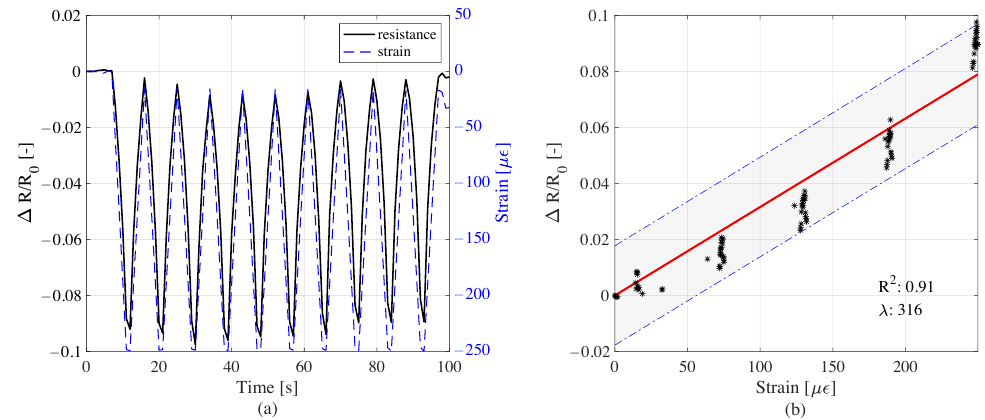
Figure 9. Sensitivity response of the beam sample under the cyclic compression load: ( a ) variation of resistance and the induced strain time histories; ( b ) resistance variation versus strain, and linear model of sensing.